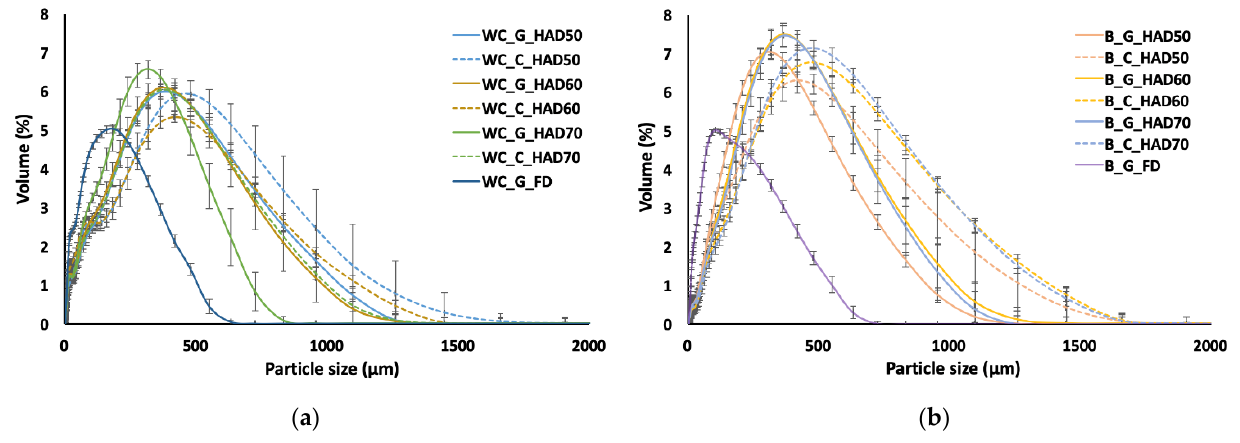
Figure 2. Particle size distribution of powders from white cabbage outer leaves ( a ) and broccoli stems ( b ). The error bars represent the standard deviation of five replicates. WC: white cabbage; B: broccoli; G: ground; C: chopped; HAD: hot-air drying at 50, 60 and 70 °C, FD: freeze drying.